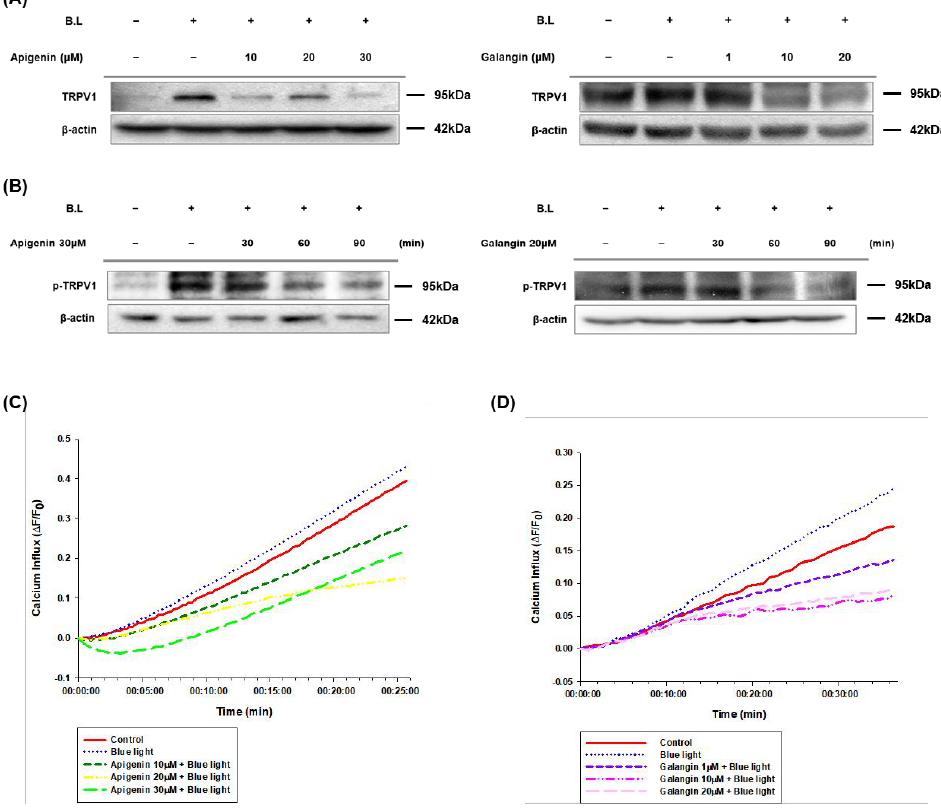
Figure 3. Apigenin and galangin reduced TRPV1 expression and its phosphorylation in blue light- irradiated HaCaT cells. ( A , B ) TRPV1 expression ( A ), and its phosphorylation levels ( B ) were deter- mined by Western blotting. ( A ) Cells were incubated with apigenin (10, 20, 30 μM) and galangin (1, 10, 20 μM) for 24 h and were then irradiated with blue light (30 min, 76 W/m 2 ). After 24 h incubation, the cells were subjected to the same process twice and were finally subjected to Western blot analy- sis. ( B ) Phosphorylation levels of TRPV1 were determined by Western blotting at 30-, 60-, and 90- min incubation after pretreatment with apigenin (30 μM) or galangin (20 μM) for 1 h and subsequent blue light-irradiation (30 min, 76 W/m 2 ). The total proteins were extracted from the cells immedi- ately after experimental conditions, and β -actin was used as a loading control. ( C , D ) Apigenin and galangin inhibited blue light-induced calcium influx in HaCaT cells. ( C ) Ca 2+ influx changes of blue light and with apigenin (10, 20, 30 μM) pretreatment, ( D ) with galangin (1, 10, 20 μM) pretreatment by Fluo- 4 NW assay. Cells were pretreated with apigenin (10, 20, 30 μM) and galangin (1, 10, 20 μM) for 1 h and irradiated with blue light (10 min, 76 W/m 2 ). After the irradiation, fluorescence intensities were measured immediately over a certain period.